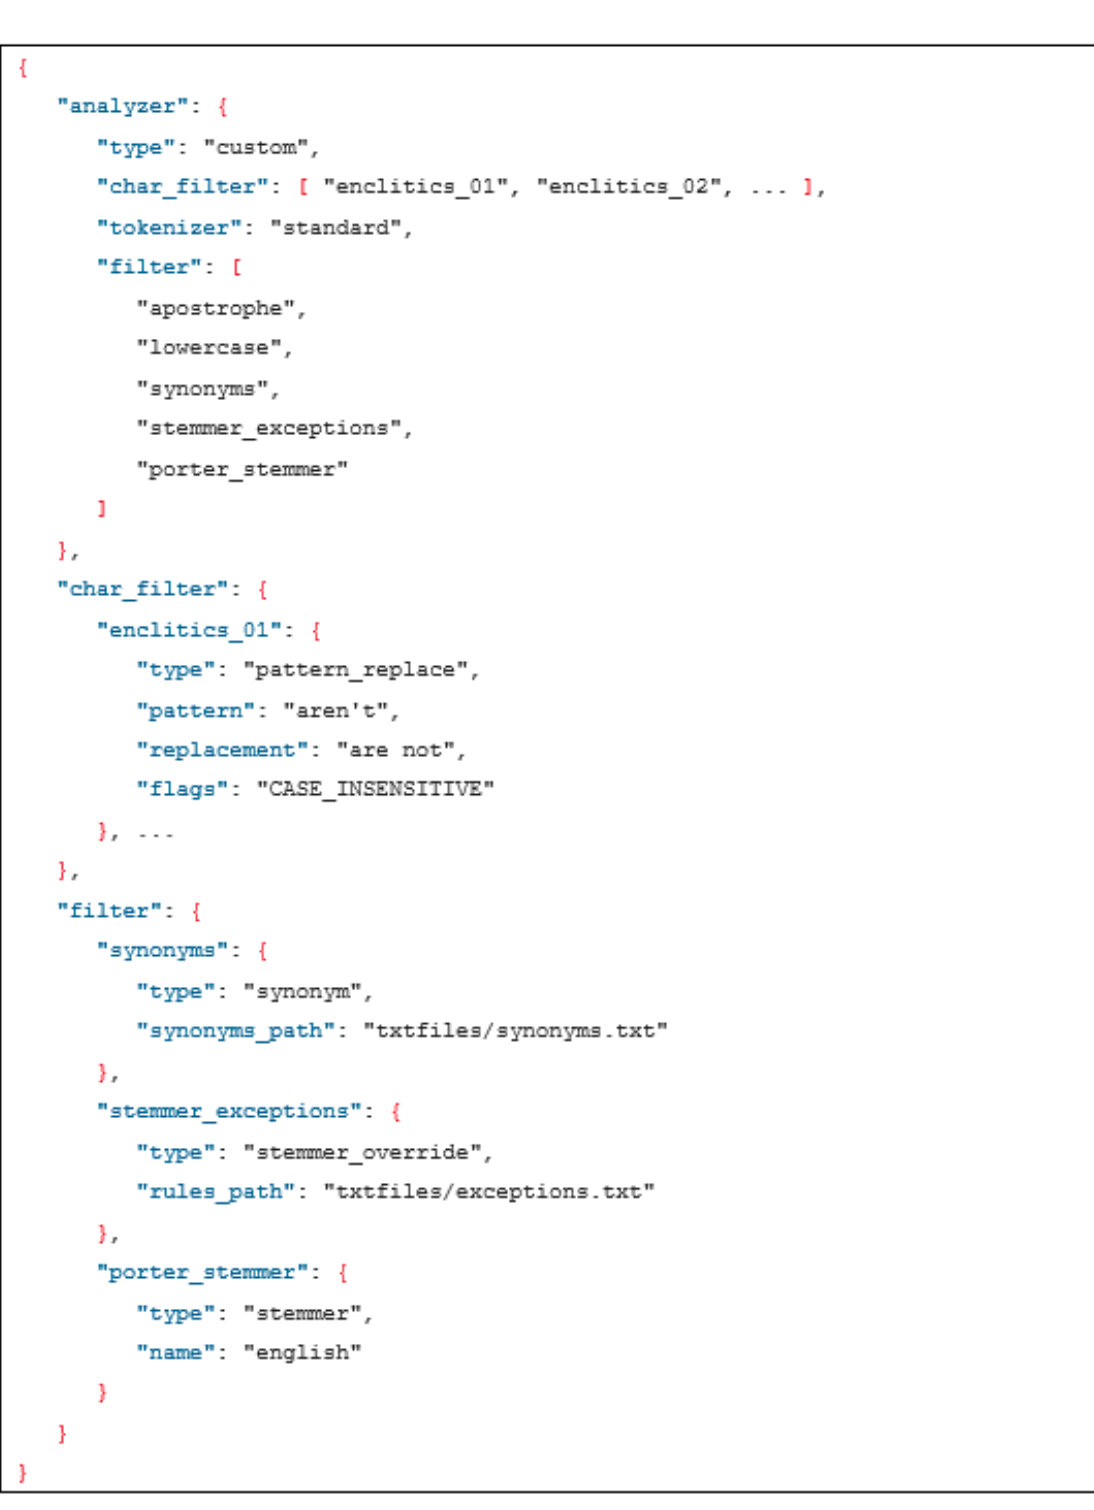
Figure 8. A custom analyser for indexing idioms.